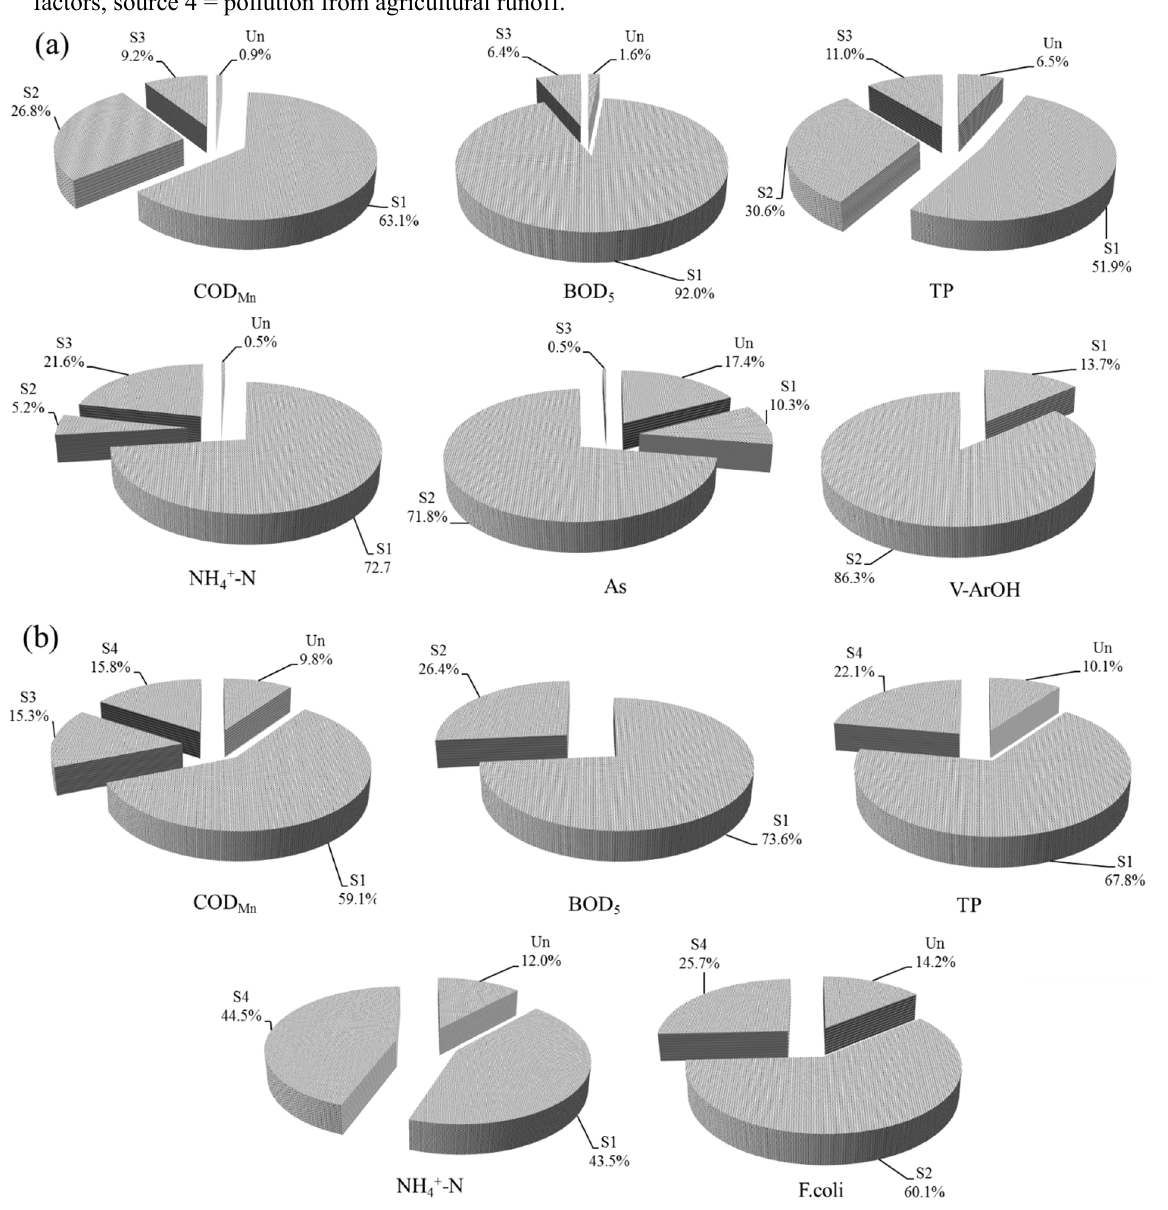
Figure 5. ( a ) Source contribution (%) to each variable in the high pollution (HP) region: Un = unexplained sources; S1 = pollution from industrial effluent, domestic sewage, and agricultural activities; S2 = pollution from chemical industrial activities; S3 = natural factors; ( b ) Source contribution (%) to each variable in the low pollution (LP)